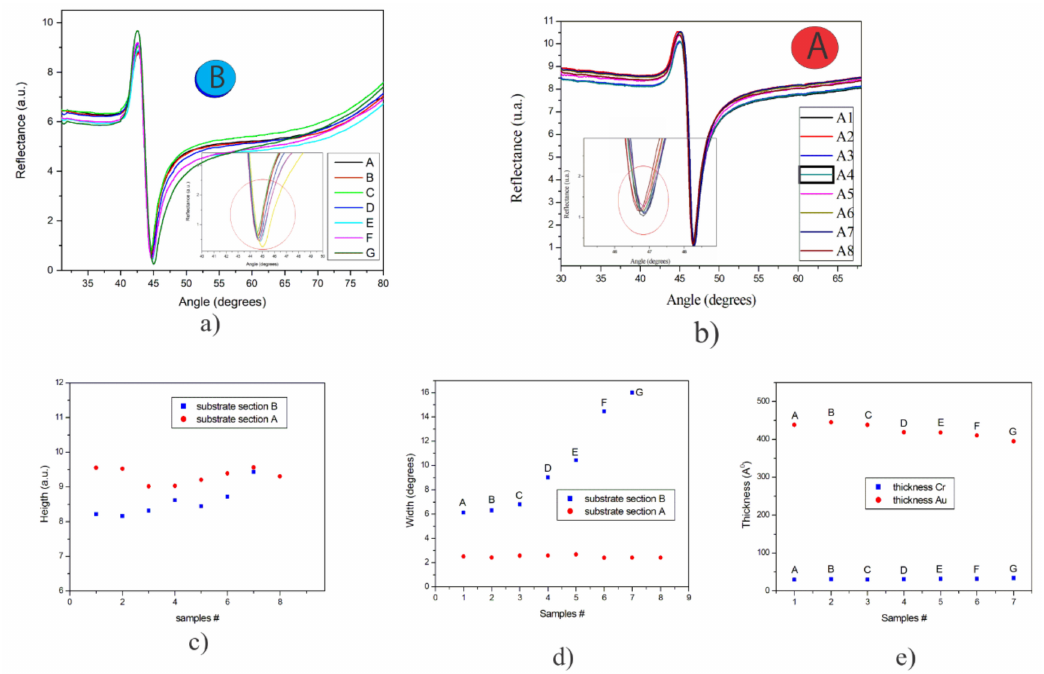
Figure 4. ( a ) SPR curves of the Cr / Au substrates of region B, ( b ) SPR curves of the Cr / Au substrates of region A, ( c ) height of SPR curves of Cr / Au substrates of regions A and B, ( d ) graph of the half-width of the SPR curves of Cr / Au substrates of the regions A and B, ( e ) estimated thickness by experimental / theoretical SPR curve fitting of Cr / Au substrates of region